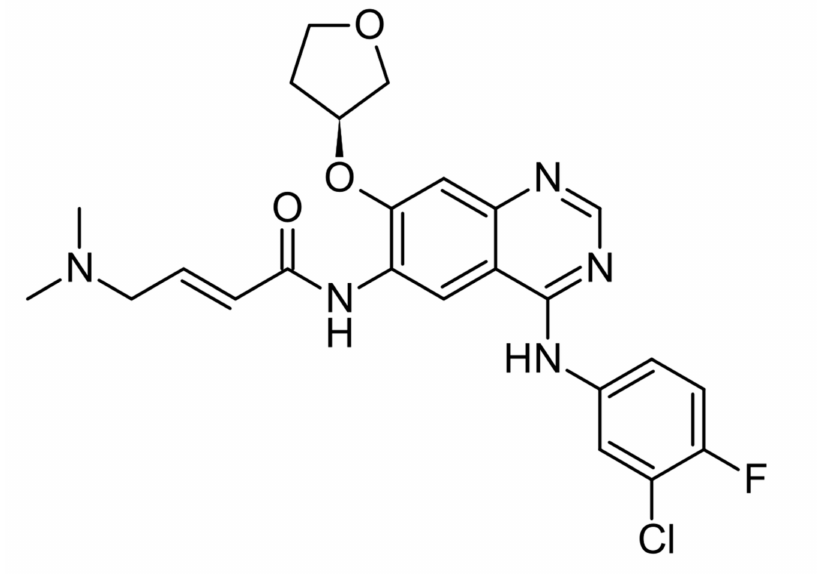
Figure 5. Afatinib—second-generation tyrosine kinase